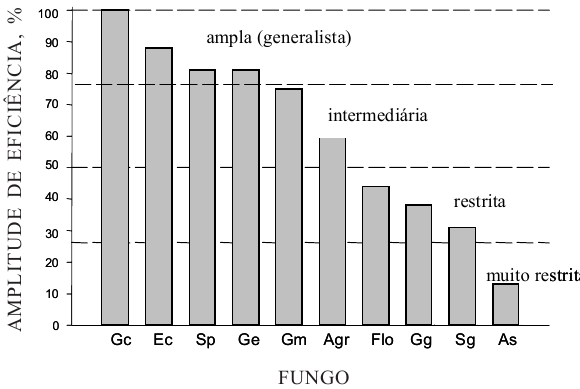
Figura 2. Índice de amplitude de eficiência dos fungos (IAE ): Gc- G. clarum , Ec-E. colombiana , f Sp S. pellucida, Ge - G. etunicatum , Gm- G. margarita, Agr-Espécies de agrossistema, Flo- Espécies de floresta, Gg- G. gigantea, Sg-